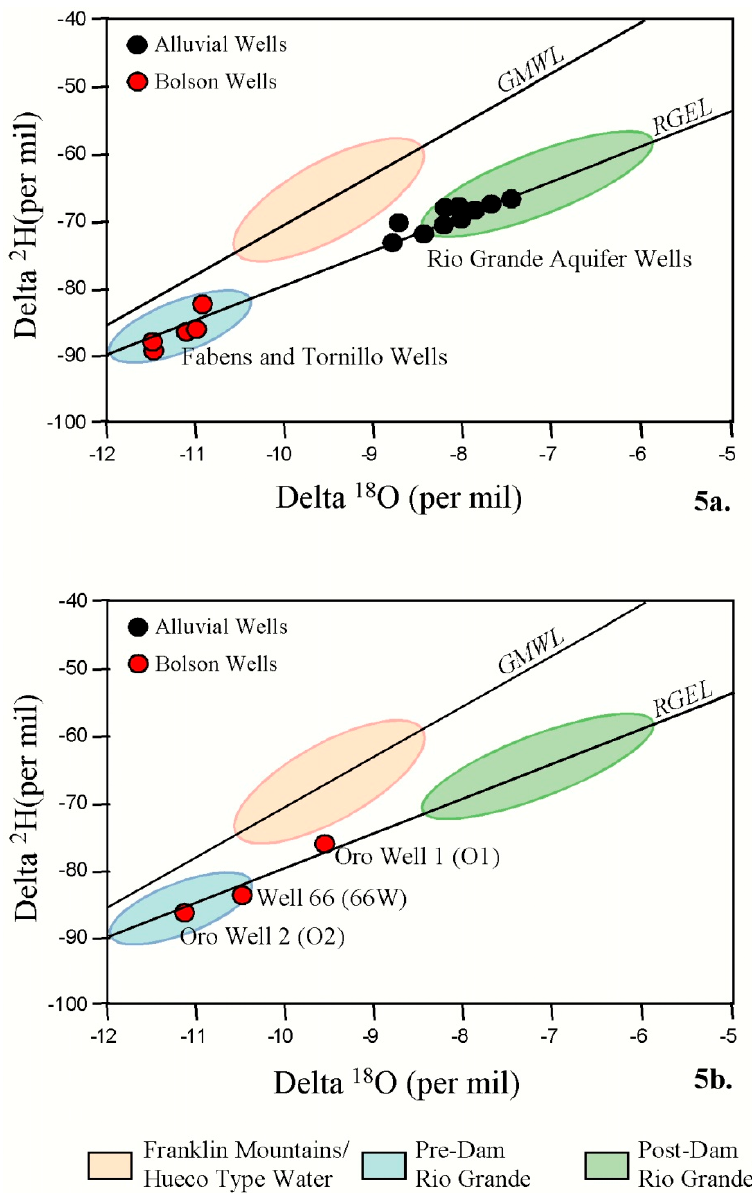
Figure 5. Rio Grande Aquifer samples plot in the post-dam Rio Grande region primarily while deeper bolson wells at the Cities of Fabens and Tornillo plot in the pre-dam Rio Grande range ( a ). Post-audit groundwater sampling for the purposes of hypothesis evaluation confirms additional well control (Well 66 and Oro Well 2) contains pre-dam water while a shallower well (Oro Well 1) near Oro Well 2 contains a mixture of pre-dam and post-dam Rio Grande water ( b ).